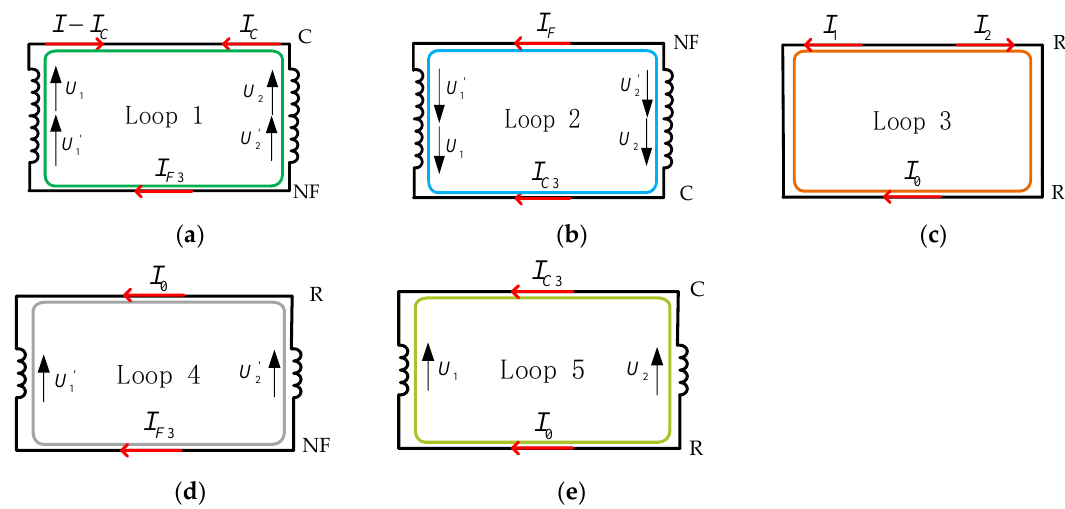
Figure 4. Current loops at the AT subsections 2 and 3 in the all parallel AT TPSS: ( a ) Loop 1 with catenary in upward direction, negative feeder in downward direction, and autotransformers; ( b ) Loop 2 with catenary in downward direction, negative feeder in upward direction, and autotransformers; ( c ) Loop 3 with rail in downward direction and upward direction; ( d ) Loop 4 with rail in downward direction, negative feeder in upward direction, and the negative winding in autotransformers; and ( e ) loop 5 with rail in downward direction, catenary in upward direction, and the positive winding in autotransformers.